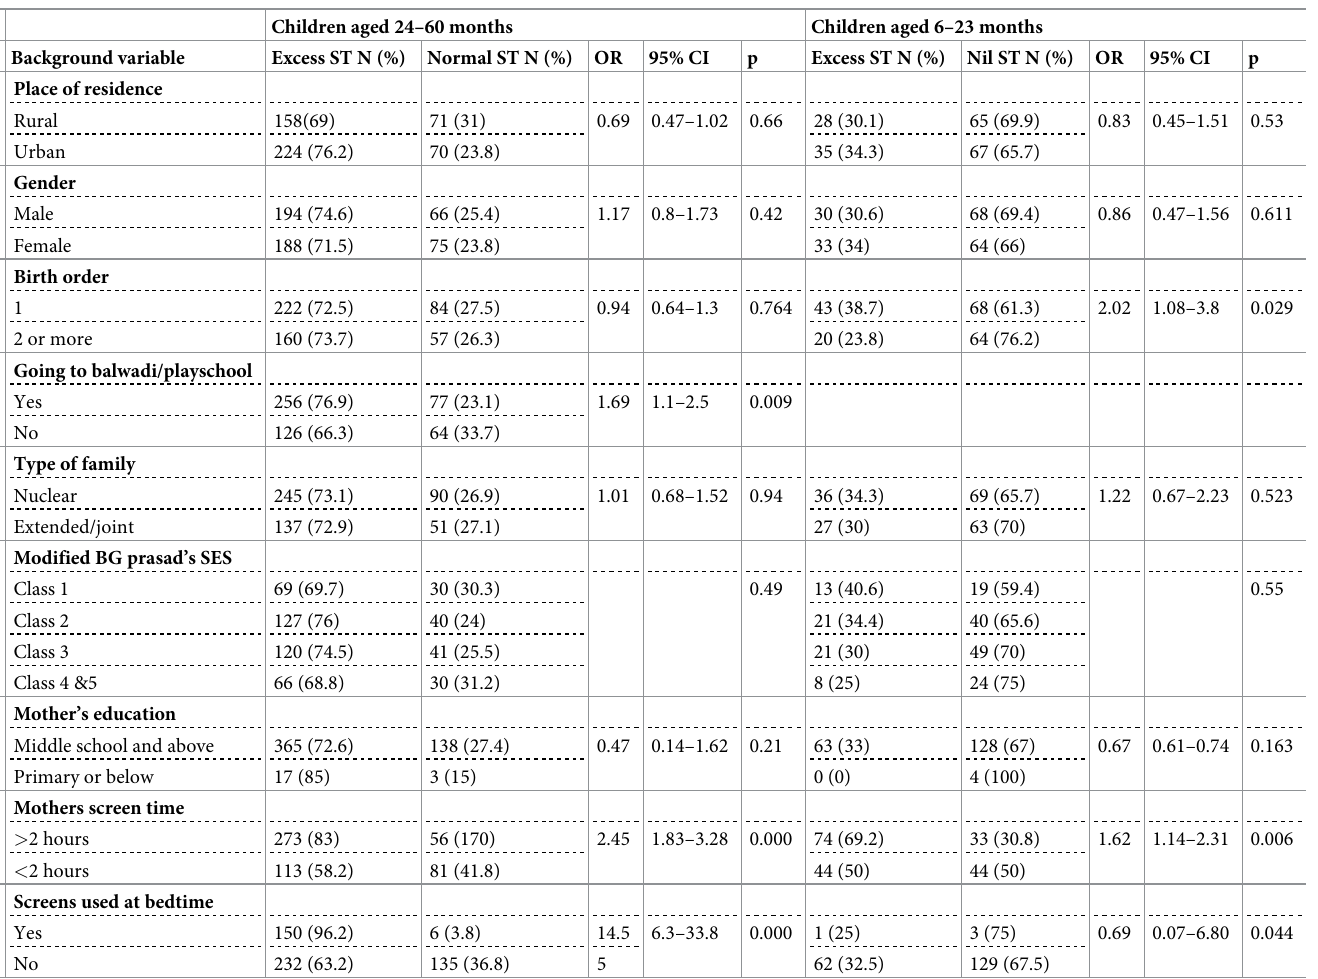
Table 3. Factors associated with screen